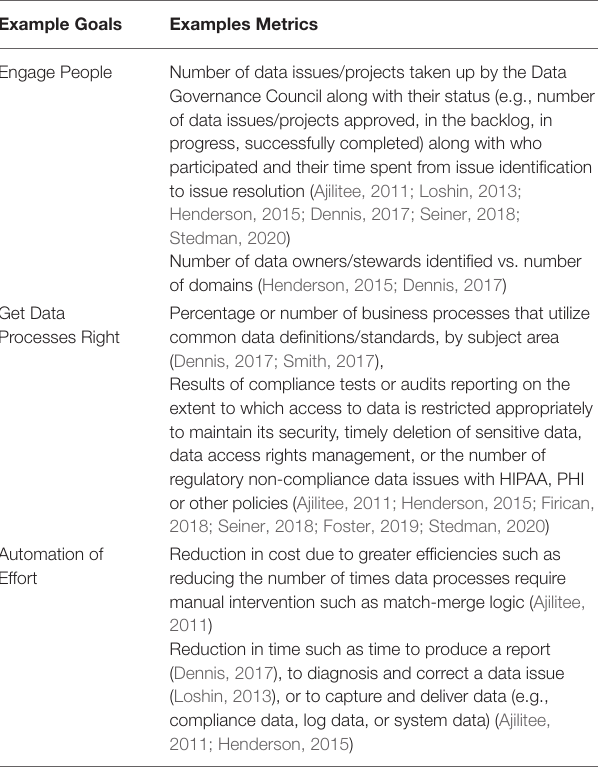
TABLE 5 | Data governance example goals and metrics. TABLE 6 | Data readiness example goals and